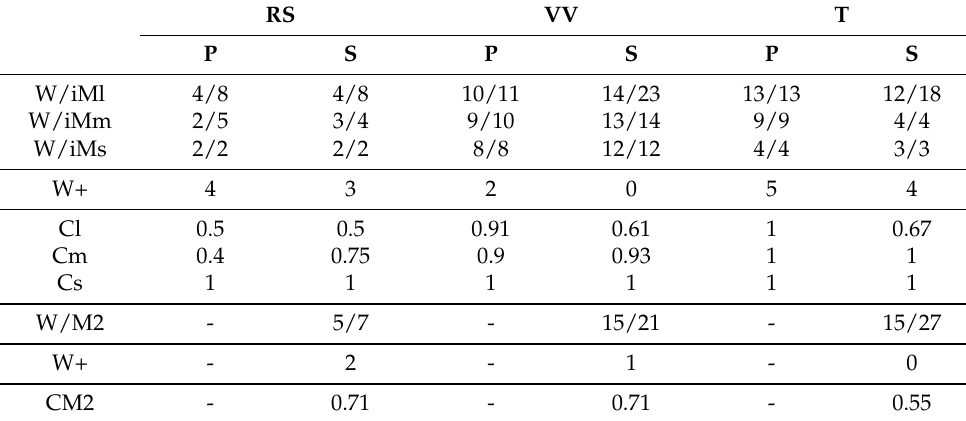
Table 3. Winet vs. iMetos ® and mechanistic 2 alarm